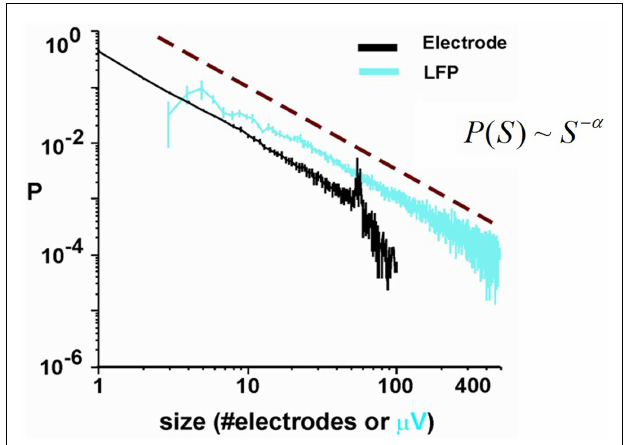
FIGURE 6 | Probability distribution of neuronal avalanche size. (Black) Size measured using the total number of activated electrodes. (Teal) Size measured using total LFP amplitude measured at all electrodes participating in the avalanche (Beggs and Plenz,